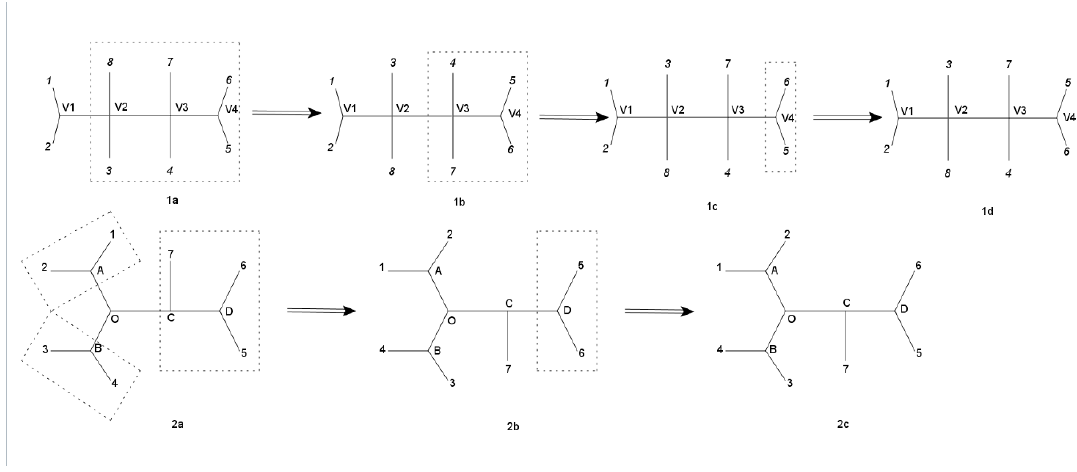
Figure 3 . The process from (cid:25) -ordering e(cid:11)ective Feynman diagram to (cid:26)